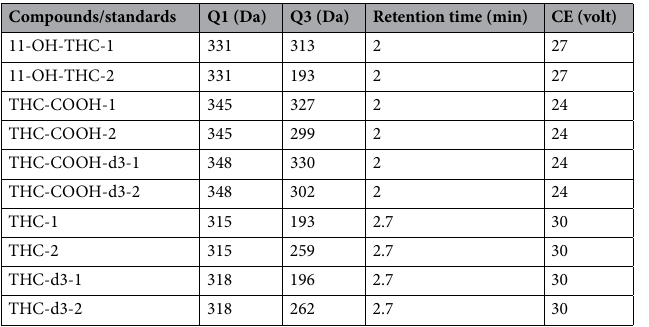
Table 1. Multiple Reaction Monitoring (MRM) Transitions and Collision Energies (CE) of different